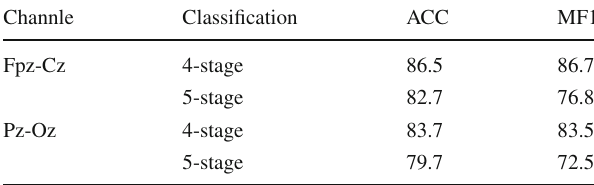
Table 3 Classification results based on different channels